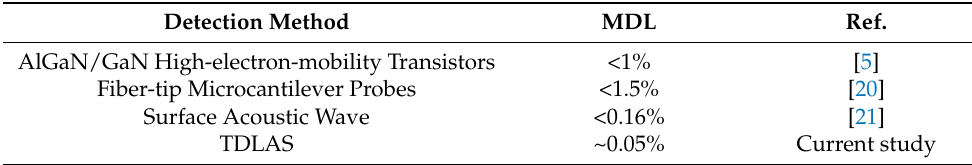
Figure 9. Allan variance analysis for the WMS-HMPC-based H 2 -TDLAS sensing system. Table 1. The properties of some H 2 sensing